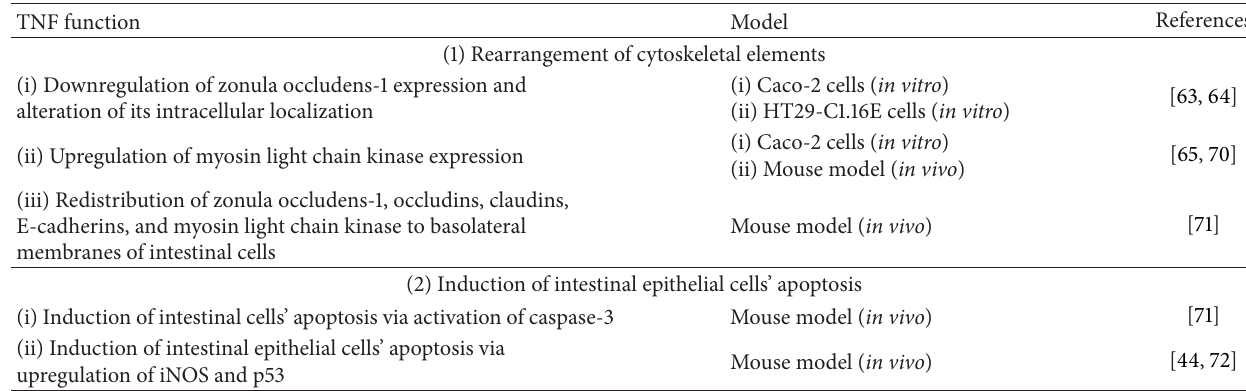
Table 2: Biological effects of TNF exerted on intestinal